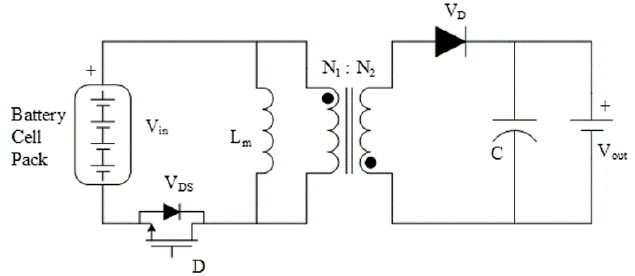
Figure 4. Typical circuit diagram of the flyback DC–DC converter.